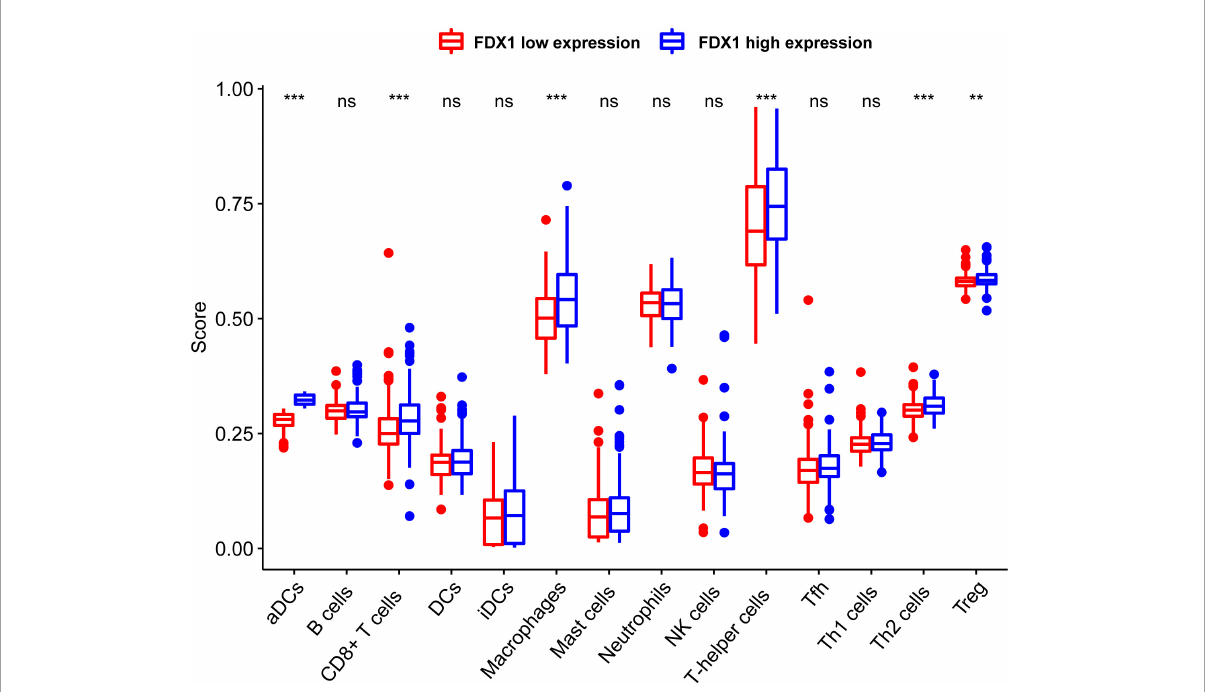
FIGURE8 The expression abundance of immune infiltrating cells in Fdx1 high and low expression group was calculated by ssGSEA method (single sample GSEA). P ≤ 0.05, ** P ≤ 0.01, and *** P ≤